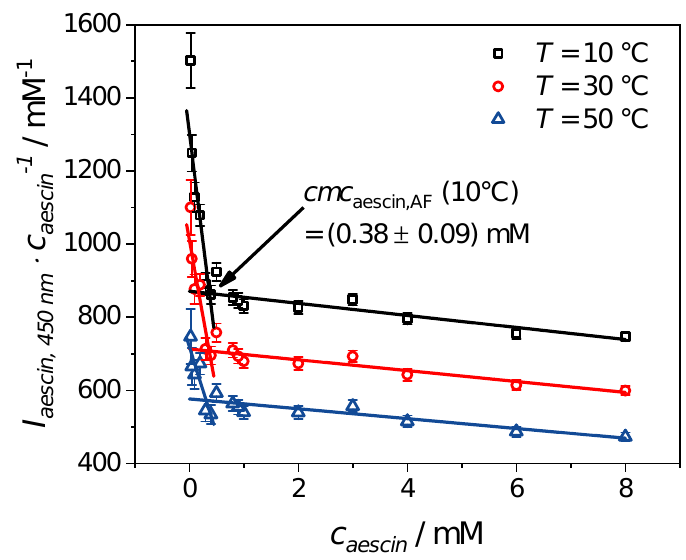
Figure 2. Autofluorescence intensity of aescin normalized with respect to each aescin concentration ( I aescin,450nm · c − 1 ) as a function of aescin concentration c aescin at temperatures of 10, 30, and 50 ◦ C. aescin The intersection of the two regressions defines the value of cmc aescin,AF for each temperature. Table 1. Temperature-dependent cmc aescin,AF values determined from aescins autofluorescence intensity (see Figure